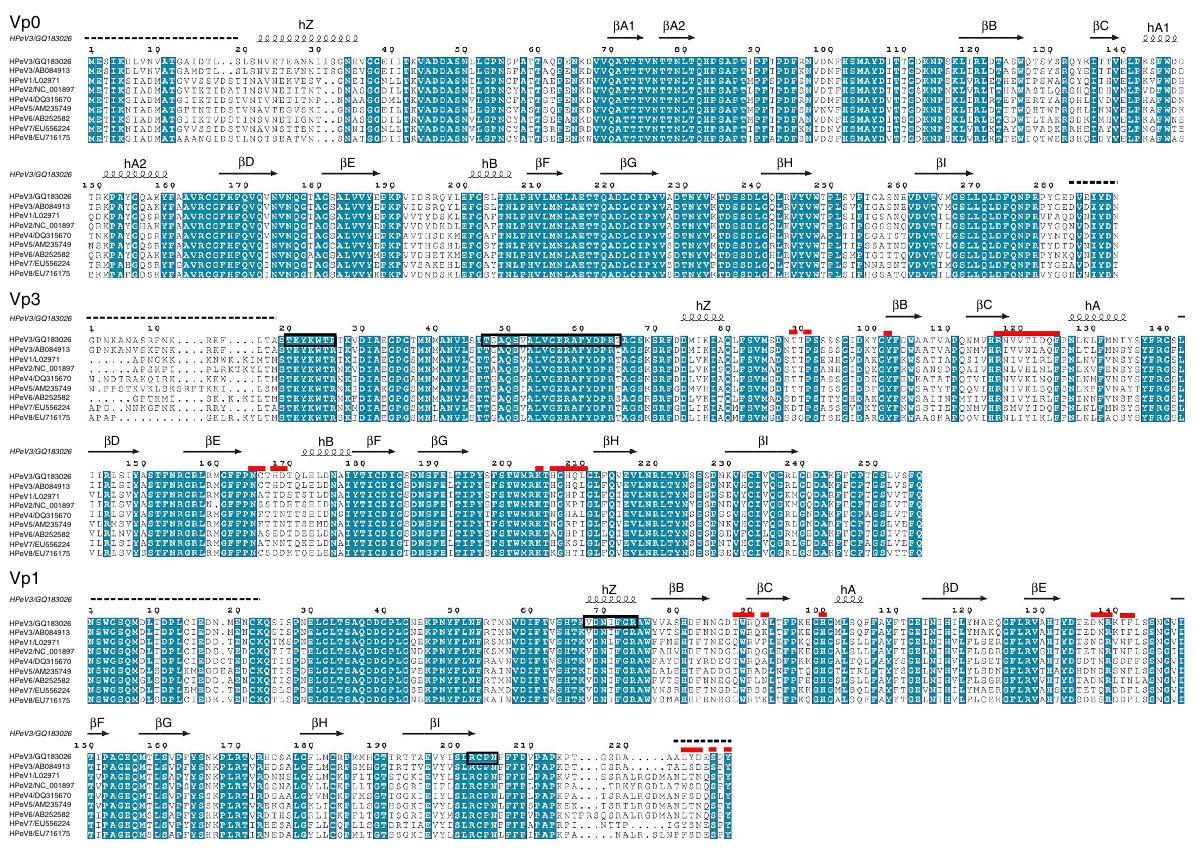
Figure 3 | Structure-based sequence alignment of human parechoviruses. Multiple sequence alignment of HPeV1-8 amino acid sequences of capsid proteins VP0, VP3 and VP1 using protein BLAST 45 is shown. The secondary structure elements from the atomic model of HPeV3 152037 are shown above the alignment as a -helices (spirals), b -sheets (arrows), disordered regions (dashed lines). Sequence annotations on the left correspond to the virus genotype/GenBank IDs. Sequence identity among all the aligned human parechoviruses (blue highlight), RNA binding sites (black boxes) and conformational epitope for mAb AT12-015 (red lines) are indicated on the HPeV3 isolate 152037 protein sequences. Disordered regions of the structural proteins were truncated from the atomic HPeV3 model. The disordered VP1 C terminus is exposed on the outside of the capsid and was identified in the footprint of Fab AT12-015 by comparison to other picornavirus structures. The footprint incorporates four amino acid differences between HPeV3 152037 and A308/99 in the variable surface loop VP3 b ChA and the C terminus of VP1. The amino acid sequence identity of 19 P1 polyproteins from all HPeV3 isolates available in GenBank is